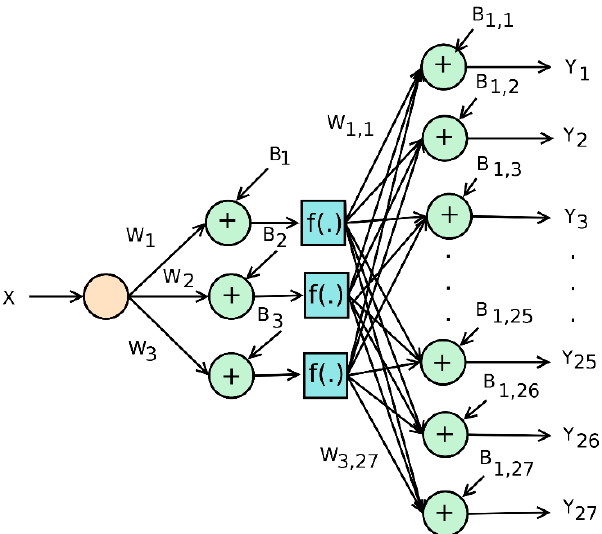
Figure 3. Architecture of the single input multiple output neural network (single input–multiple output